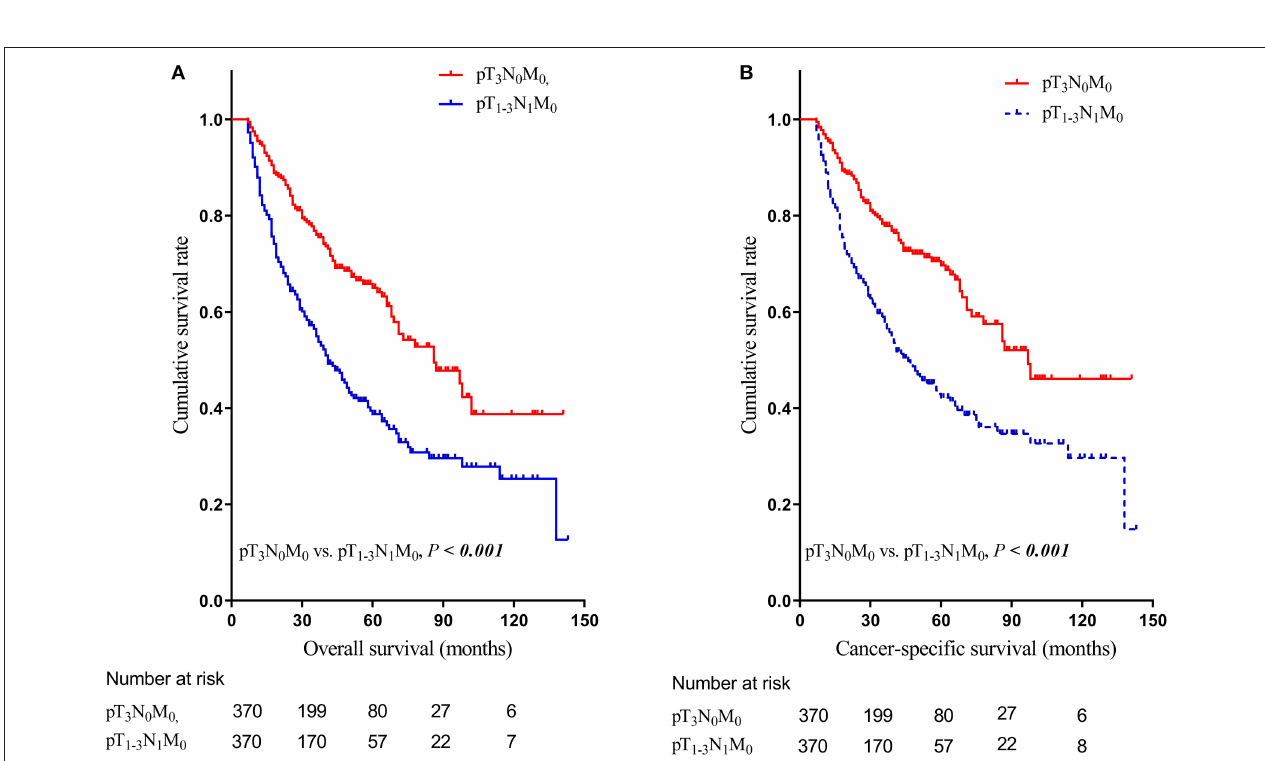
FIGURE 3 | Kaplan-Meier estimation of overall survival curves (A) and cancer-specific survival curves (B) relative to stage III-N0 (pT 3 N 0 M 0 ) and stage III-N1 (pT 1 − 3 N 1 M 0 ) groups after matching.